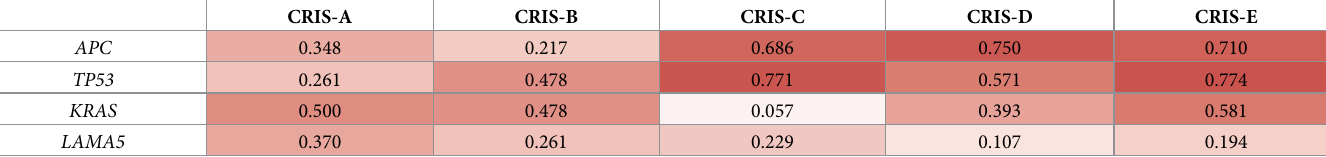
Table 8. Probabilities of source aberration with downstream target for colon cancer subtypes. For CRIS-class subtypes of colon cancer, the heatmap represents the probabilities that the indicated gene is a DNA-aberrant source gene with some downstream RNA-aberrant target. The sources are selected from the set of core genes for coverings of the given tissue; the selection criterion is that the probability of a DNA-aberration is high for at least one of the subtypes for that tissue. CRIS-A